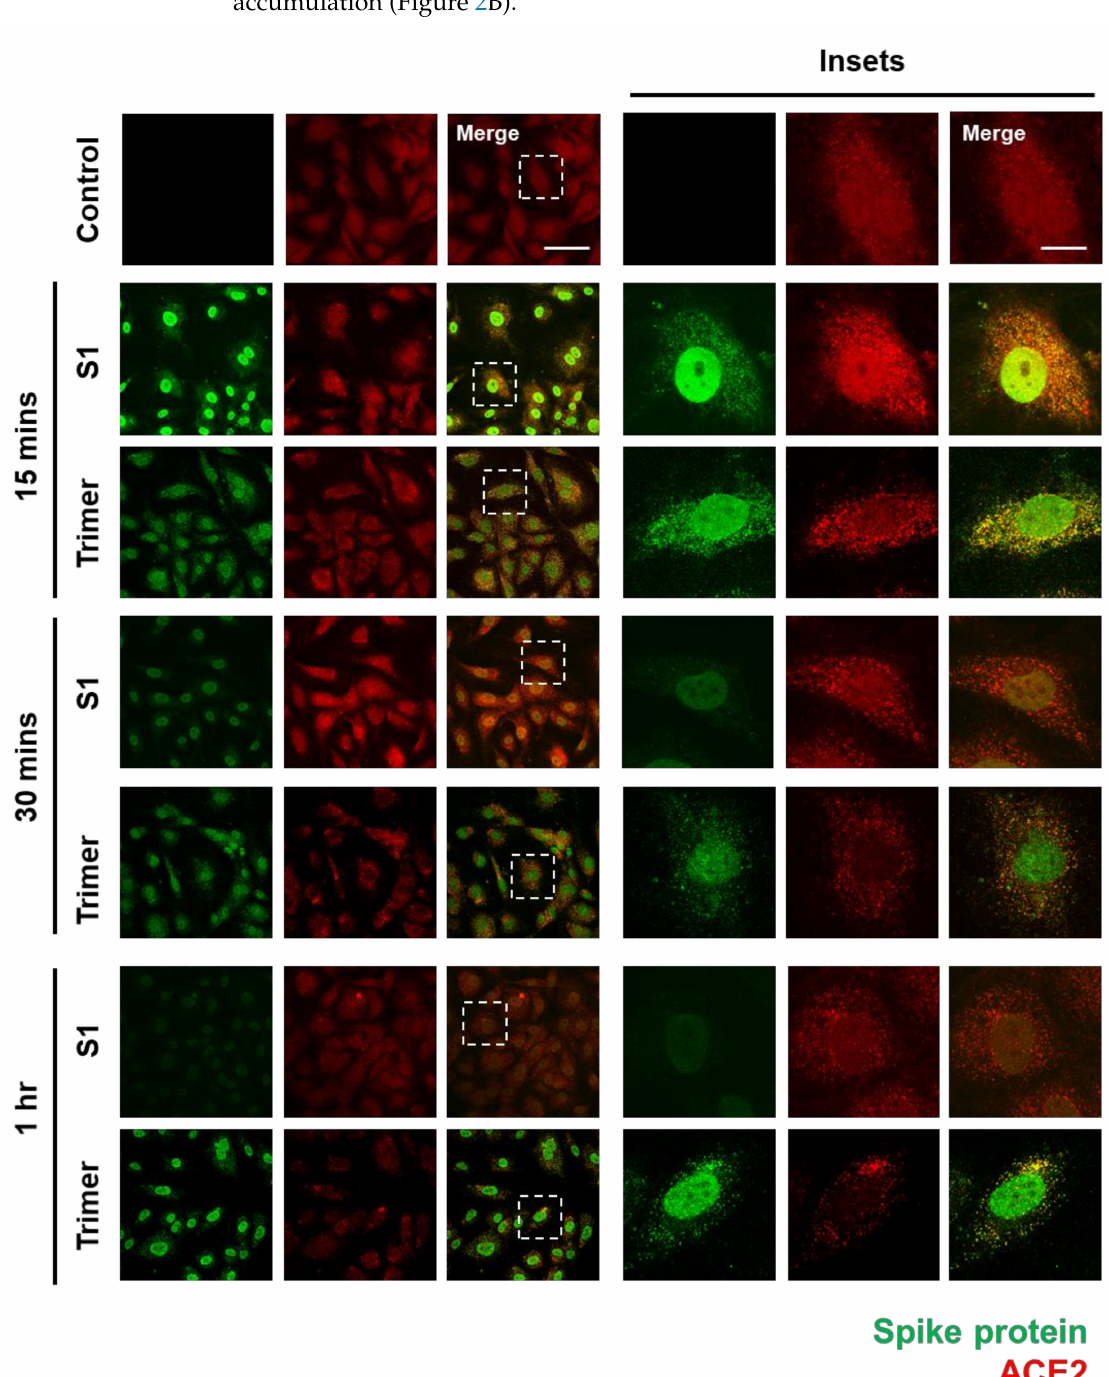
Figure 1. The spike proteins are internalized into the human brain ECs through ACE2. An amount of 15 nM of receptor binding domain (RBD) of spike protein (S1) and active trimer (Trimer) were treated on the primary human brain ECs for different time points up to 1 h, respectively. Cells were stained with spike protein (green) and ACE2 (red) antibody. Insets indicate magnified images of dashed lines. Scale bar, 75 µ m (left panel); 20 µ m (right